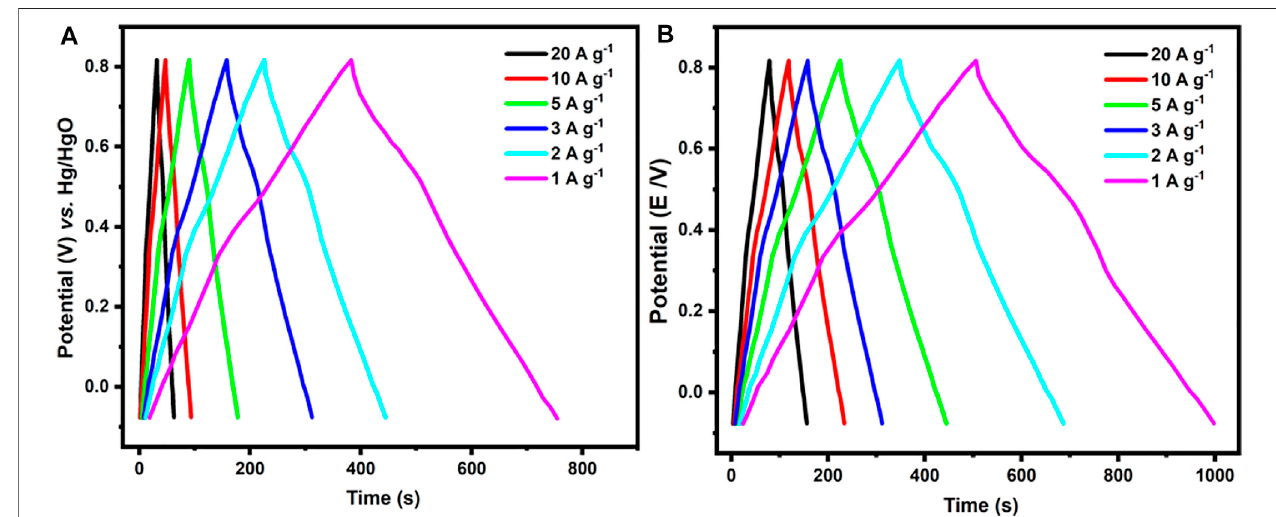
FIGURE 9 | GCD curves of (A) p-2CzPN and (B) p-4CzPN polymers tested at various current densities.